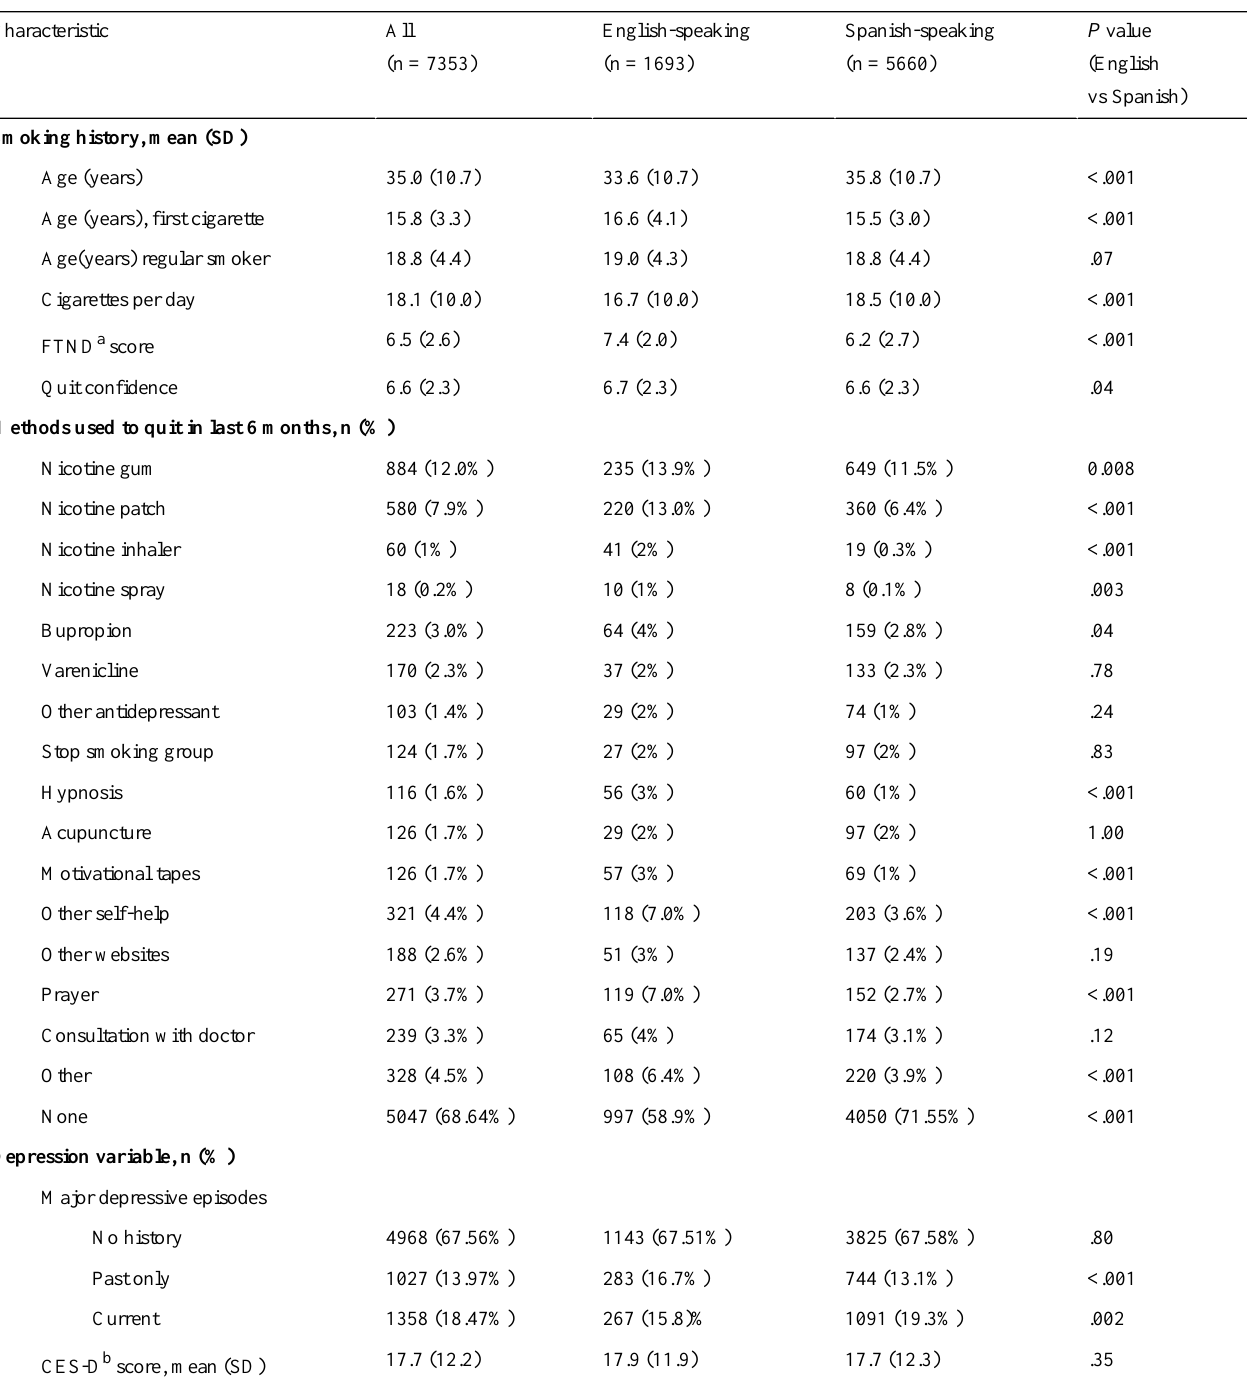
Table 2. Smoking and clinical characteristics of consenting